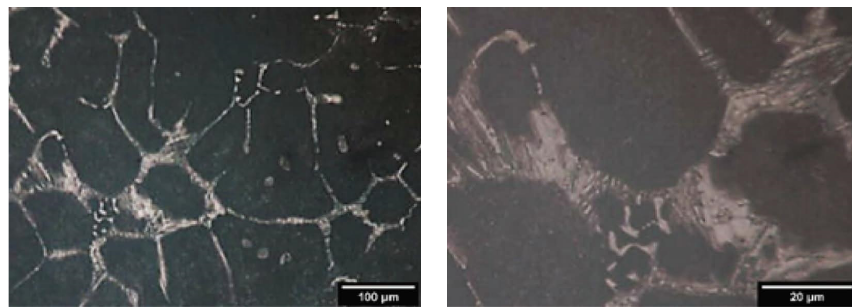
Figure 6: Microstructure of 4V-3W steel in the as-cast condition.